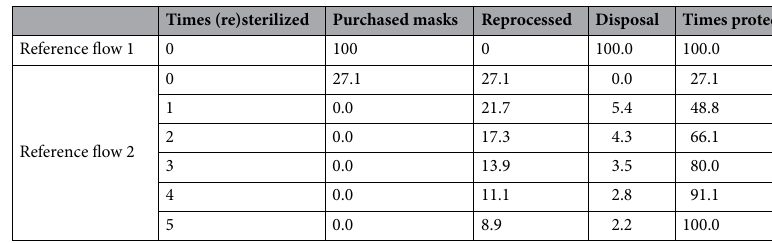
Table 1. Comparison between reference flow 1 and